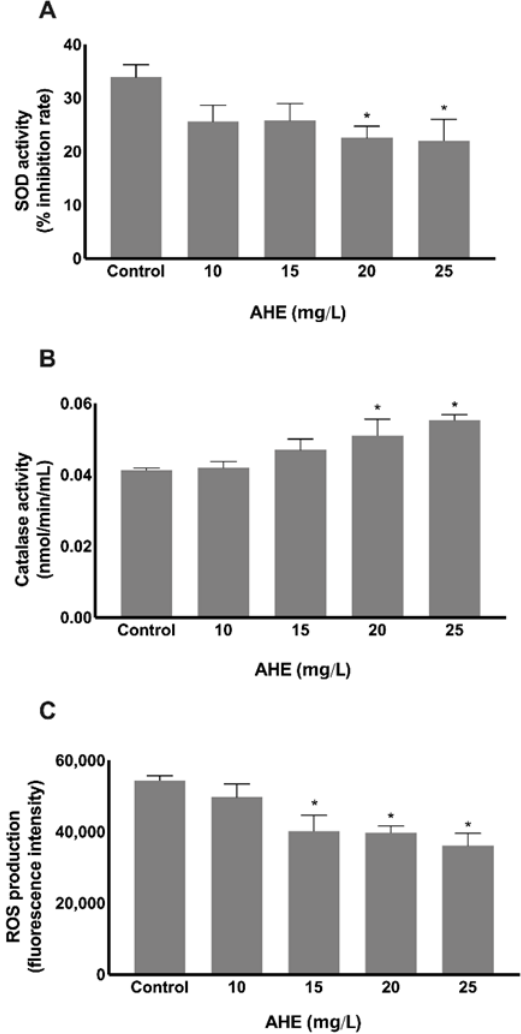
Figure 5. Evaluation of oxidative stress mediators after HMEC-1 treatment with AHE or control. Antioxidant SOD ( A ) and catalase ( B ) defenses were both augmented at concentrations of 20 and 25 mg/L, in comparison with control group, analyzed by enzymatic assays. Production of reactive oxygen species (ROS) was reduced dose-dependently, measured after incubation with fluorescence dies, with statistical significance at 15 mg/L or higher ( C ). Results are presented as % inhibition rate of SOD activity ( A ) nmol of catalase activity/min/mL ( B ) and units of fluorescence intensity for ROS production ( C ) * p < 0.05 vs. control.